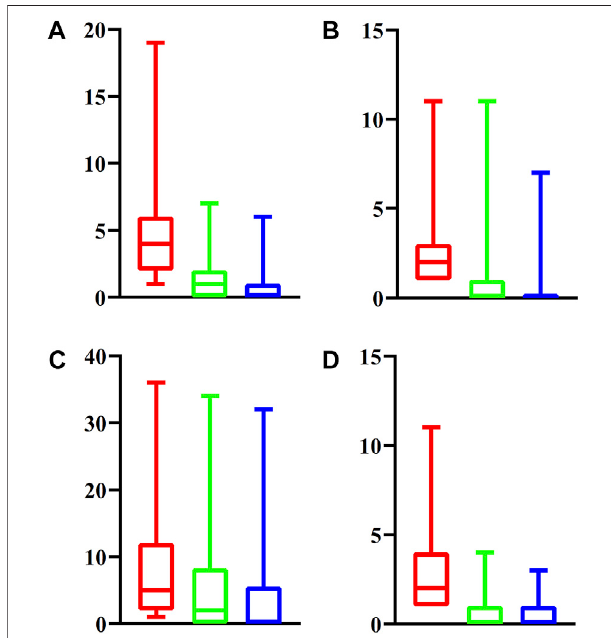
FIGURE 2 | Boxplot to show the associations between latent driver genes and validated ones at each of four omic levels. (A) Epigenomics; (B) Genomics; (C) Transcriptomics; (D) Post-transcriptomics. The Y -axis represents the number of validated genes that can interact with latent genes with different strength. The red (green, blue, respectively) box denotes number of validated genes that can interact with latent genes with medium (high, highest, respectively) con fi dence.